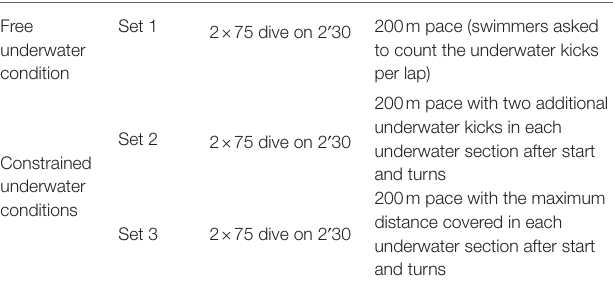
TABLE 1 | Experimental protocol of competitive swimmers to evaluate the role of the underwater swimming on biomechanical and physiological parameters. Free underwater condition